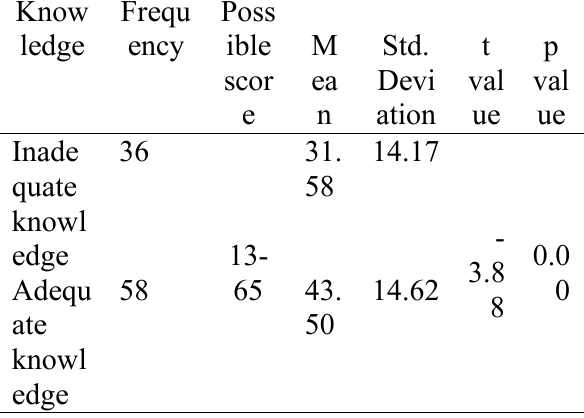
Table 12: Comparison between mean